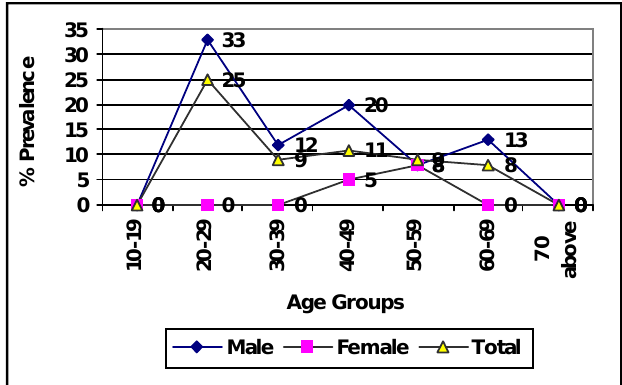
Fig.1: Age and sex prevalence of tuberculosis by sputum smear